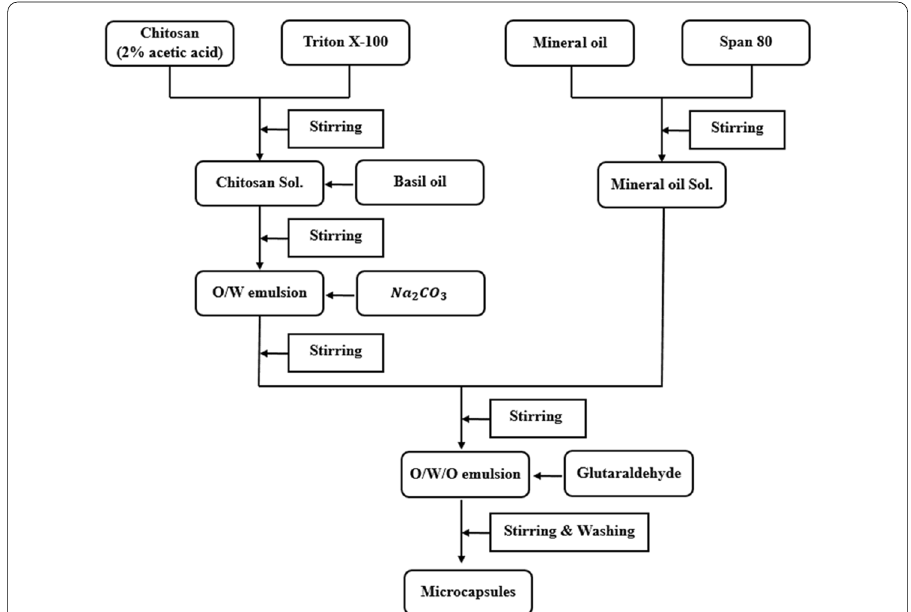
Fig. 2 Manufacturing process of crosslinked chitosan microcapsules by multiple emulsification